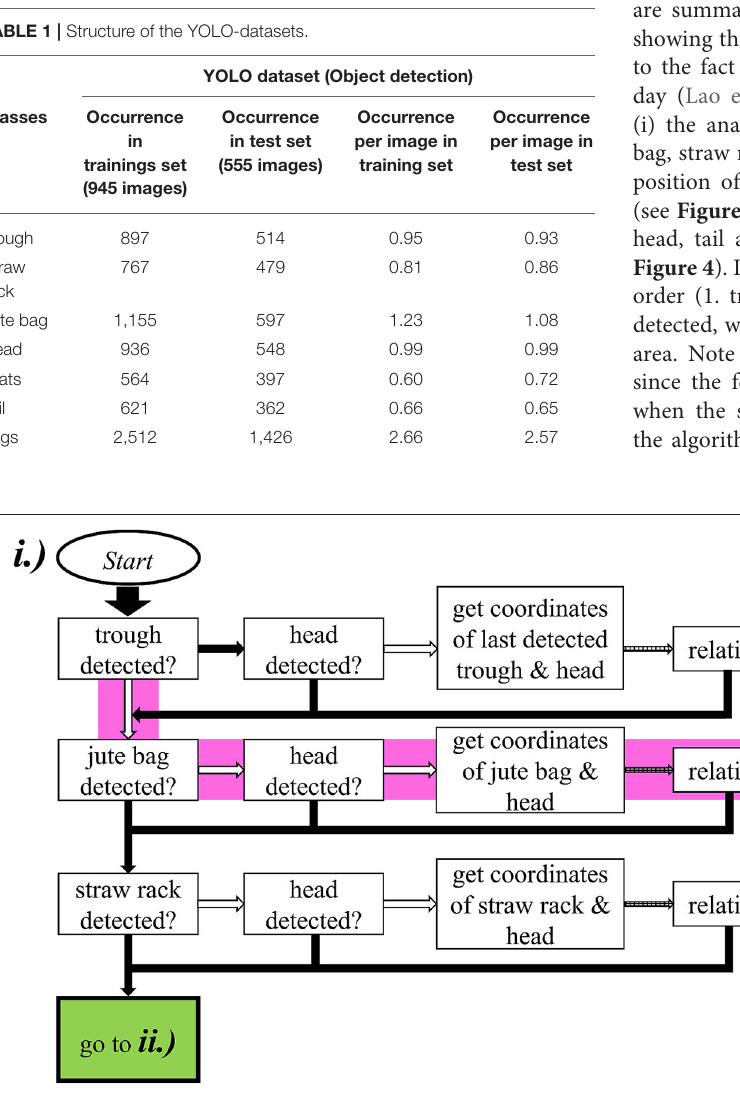
Frontiers in Animal Science |